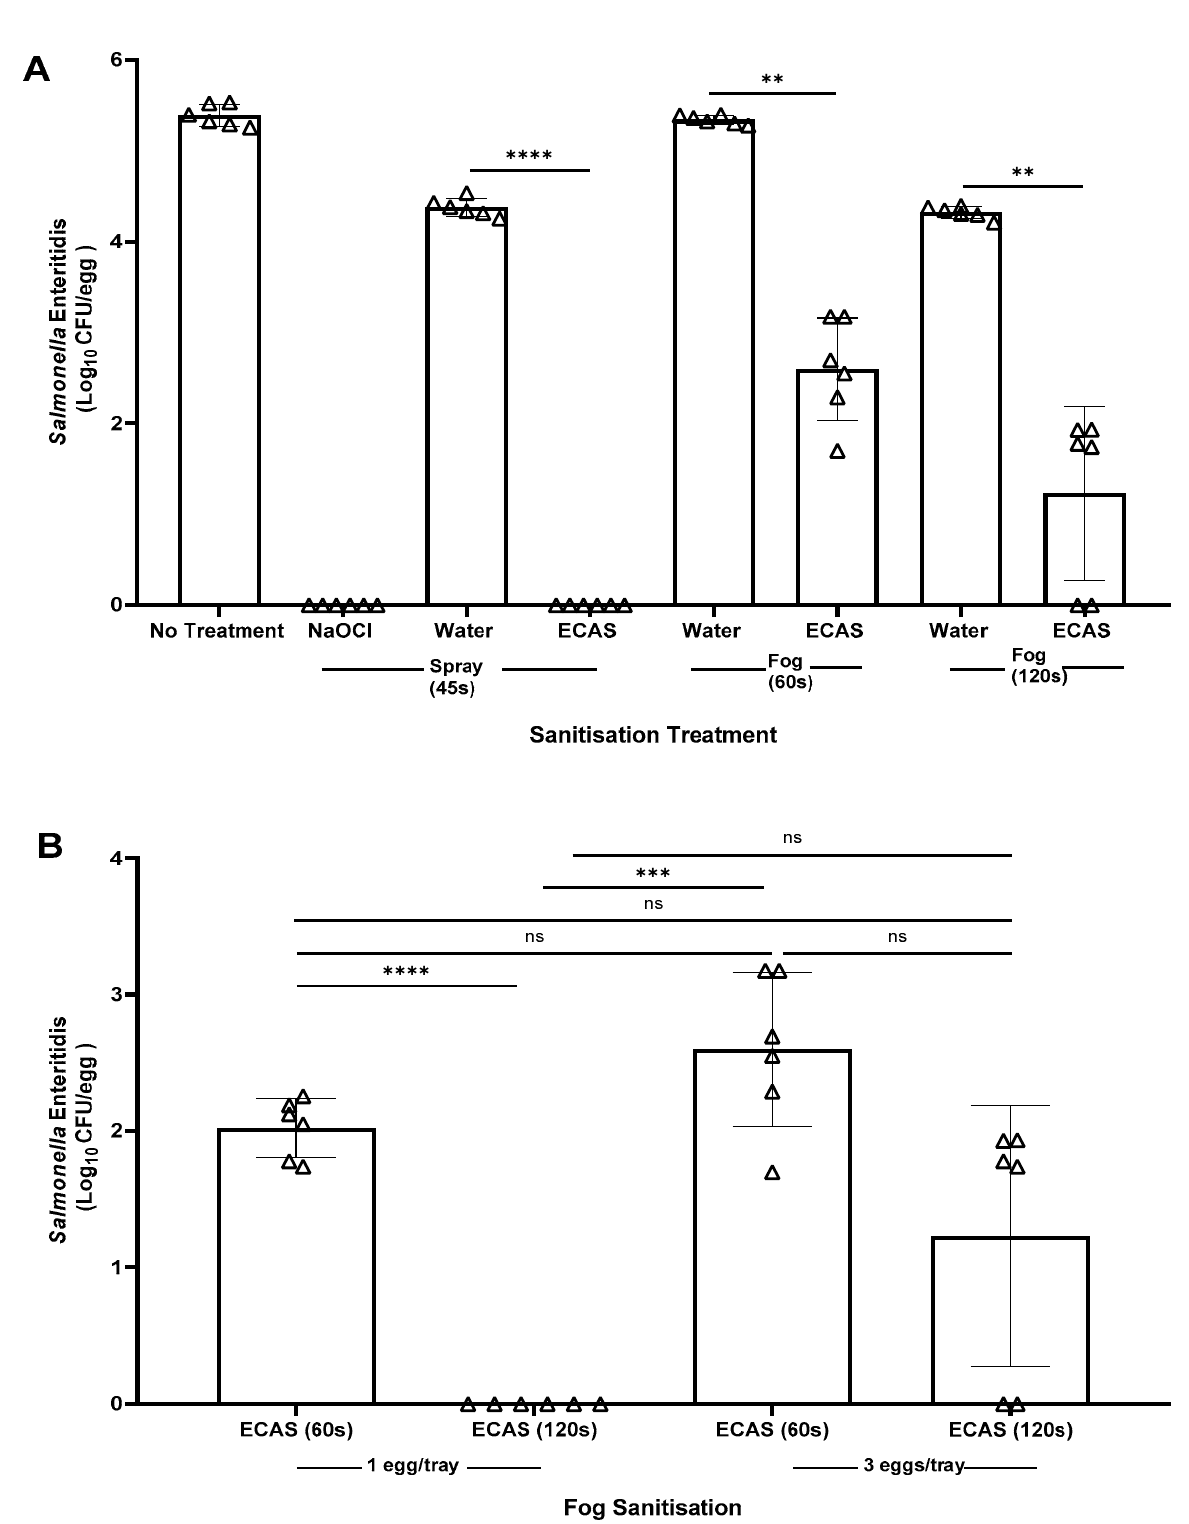
Figure 2. Effectiveness of sprayed and aerosolised ECAS on reduction of S. Enteritidis counts. ( A ) S. Enteritidis counts after the various sanitisation treatment. ( B ) Aerosolised ECAS sanitisation of individual (one egg/tray) and simultaneous (three eggs/tray) treated eggs for 60 s and 120 s. NaOCl—sodium hypochlorite (~200 mg/L FAC); ECAS—electrochemically activated solution (150 mg/L of FAC); ns—not significant; ** p < 0.01, *** p < 0.001, **** p < 0.0001.